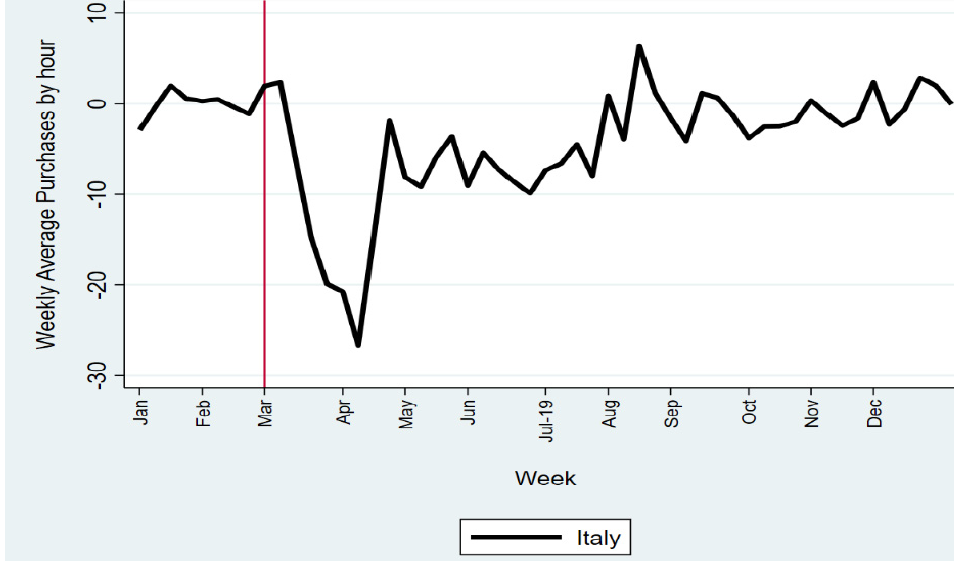
Figure 6. Relative Annual Variation (2020 vs. 2019) of Equilibrium Quantity (Total Purchases)- Weekly Average.